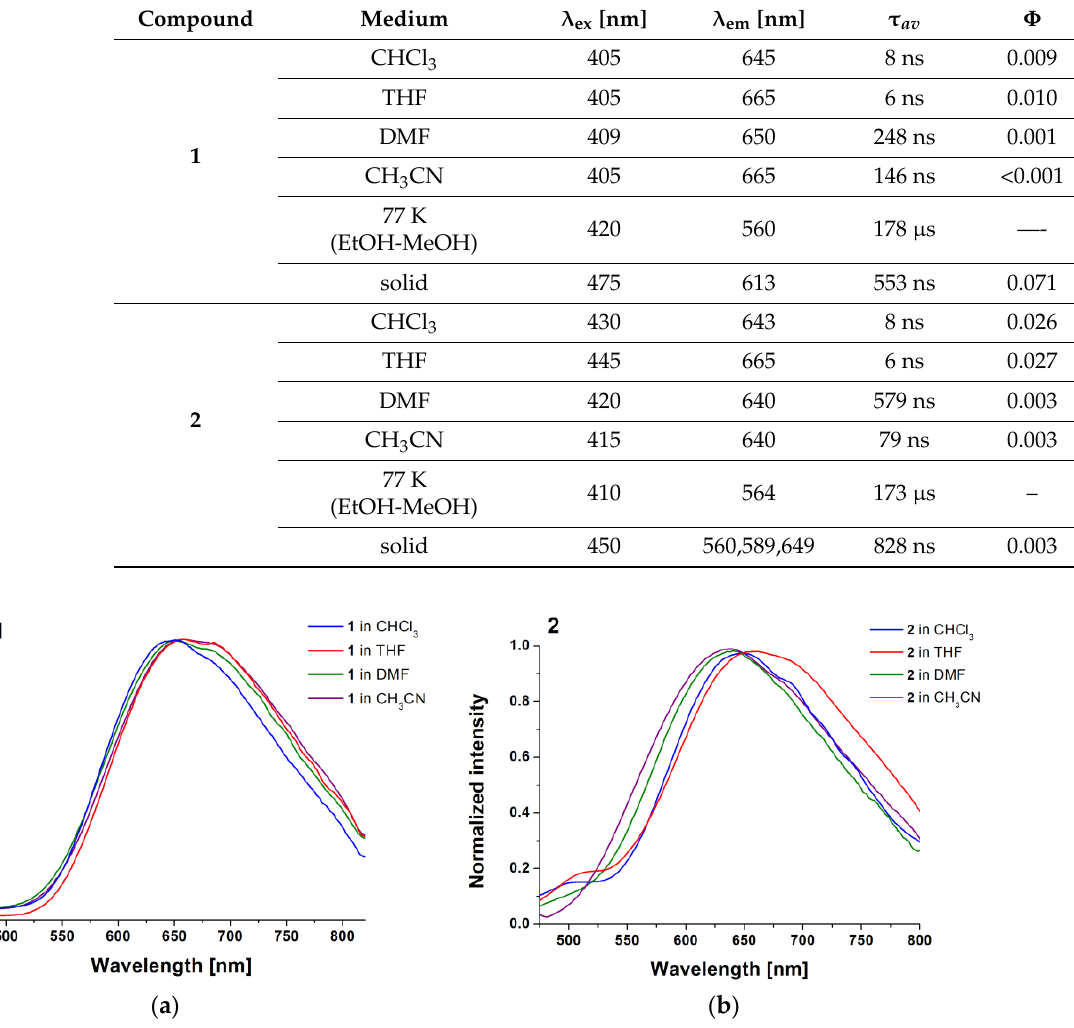
Figure 4. Normalized photoluminescence spectra of 1 ( a ) and 2 ( b ) in different environments.